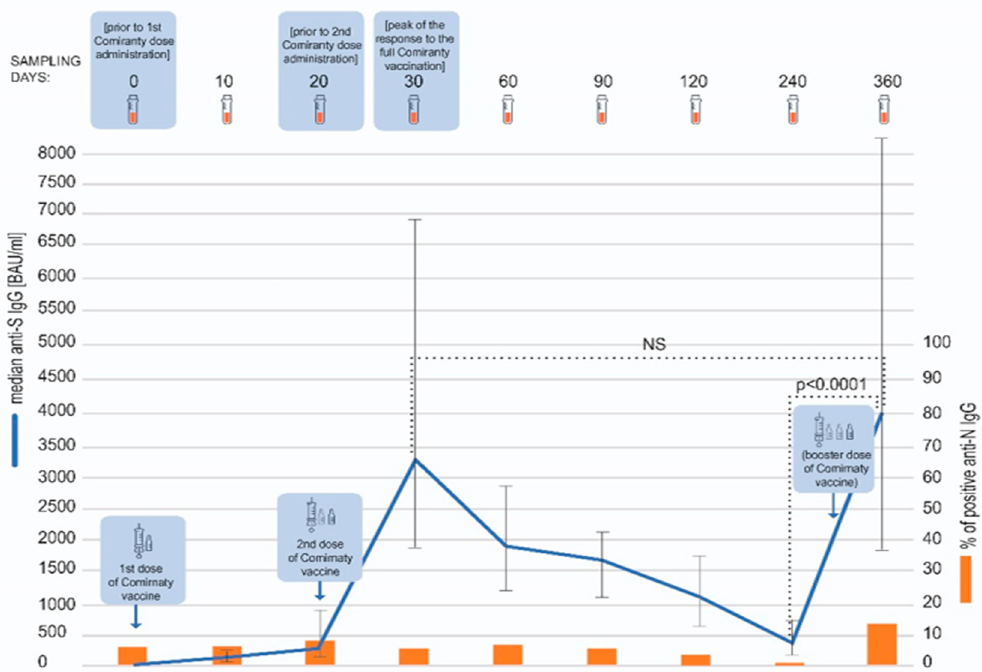
Figure 1. The model of the study. The concentrations of anti-spike SARS-CoV-2 IgG antibodies at different timepoints are presented as medians and interquartile ranges (Q25, Q75). Over the course of the study, anti-S concentrations peaked twice—after the second dose (day 30) and then after the booster (day 360) (blue line). The dotted lines indicate statistical significance of the differences in the antibody concentration between the investigated timepoints, as assessed with Wilcoxon test. The percentage of the subjects testing positive for anti-nucleocapsid SARS-CoV-2 IgG antibodies (orange bars) was relatively low throughout the study, but a rise was visible on day 360.